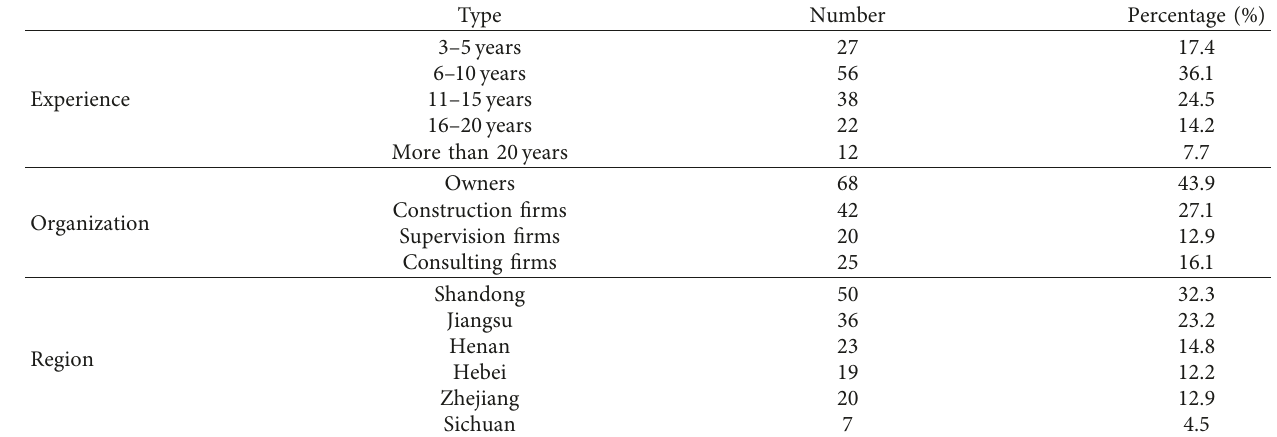
Figure 1: Structure model and hypotheses. Table 1: Respondent